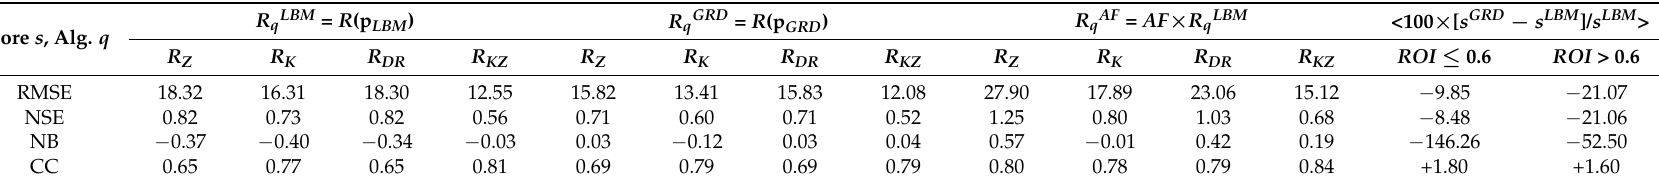
Table 2. Scores of the radar vs. rain gauge daily accumulations on 12 October 2012. K dp _ min = − 1.5 deg/km. The best value in each row is in boldface. The error scores are defined in Appendix B *.